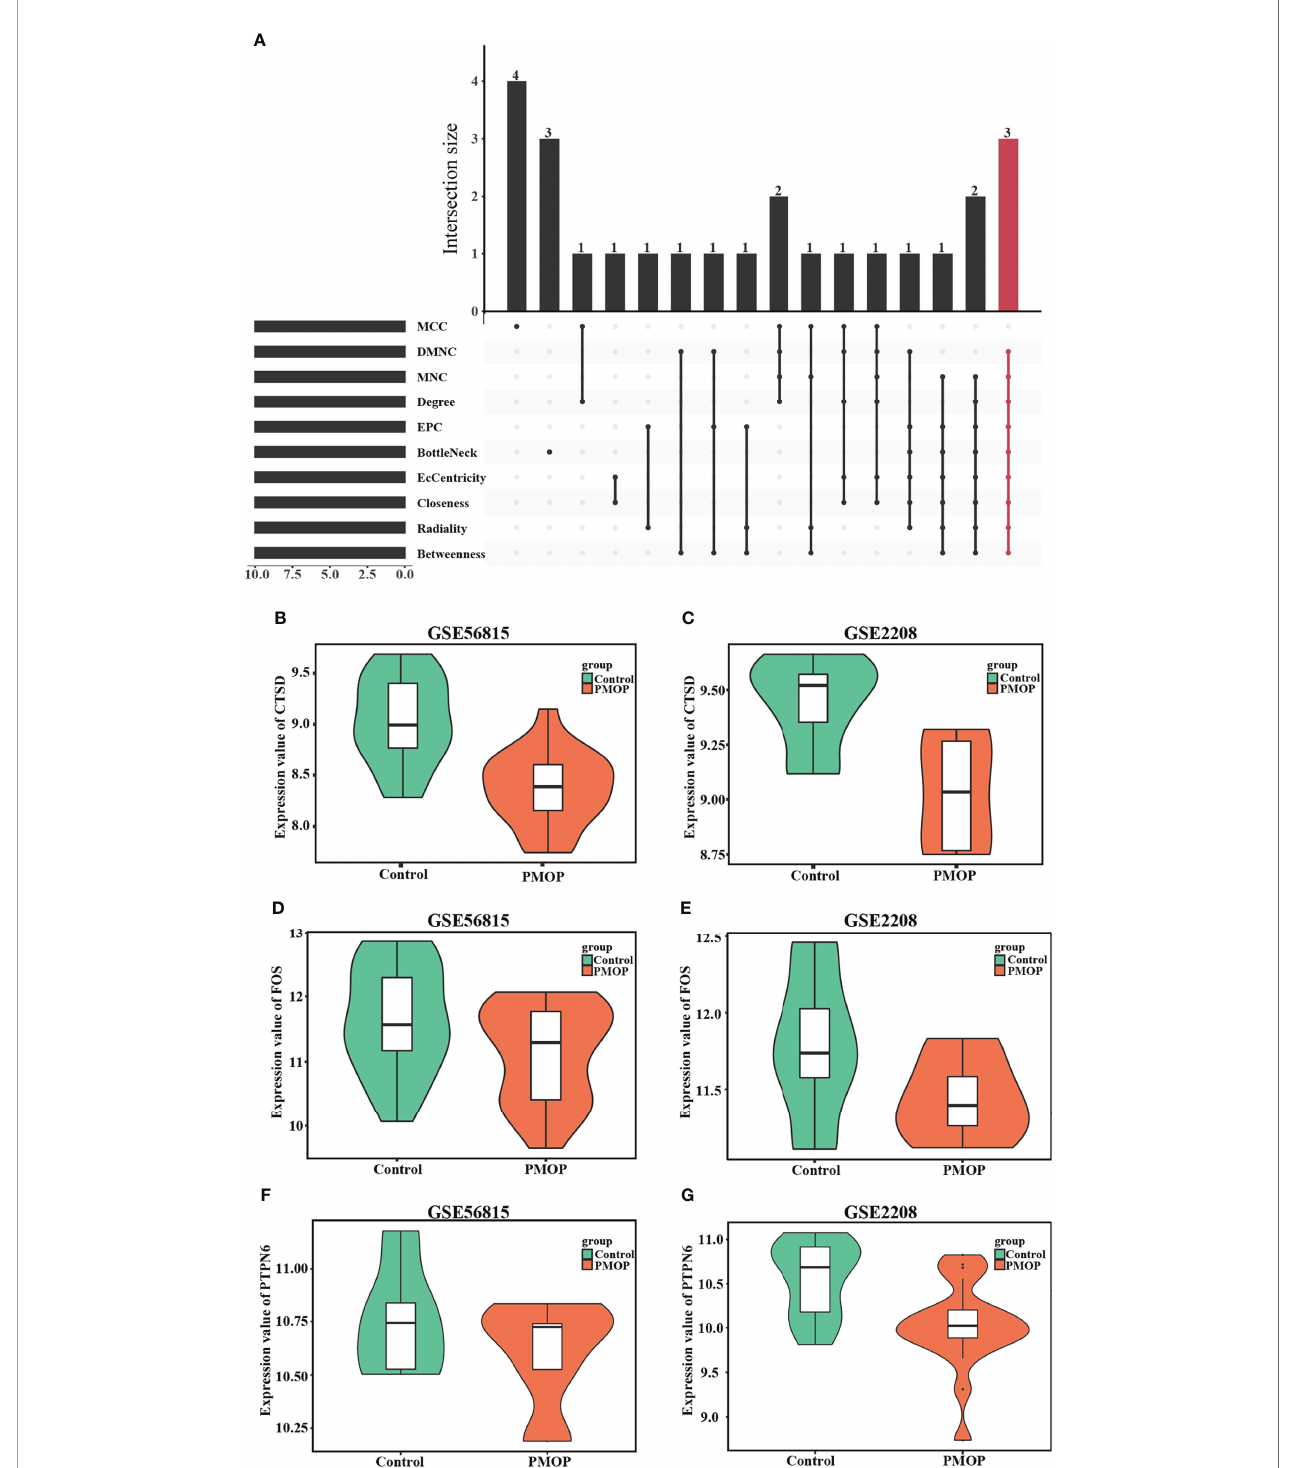
FIGURE 6 | Identi fi cation of hub genes and Boxplot of hub genes that expressed consistently across two datasets. (A) Hub genes were identi fi ed by intersection of 50 genes from 10 algorithms, namely, MCC, DMNC, MNC, Degree, EPC, BottleNeck, EcCentricity, Closeness, Radiality, and Betweenness. The consistent expression of CTSD in (B) GSE56815 and (C) GSE2208. The consistent expression of FOS in (D) GSE56815 and (E) GSE2208. The consistent expression of PTPN6 in (F) GSE56815 and (G)